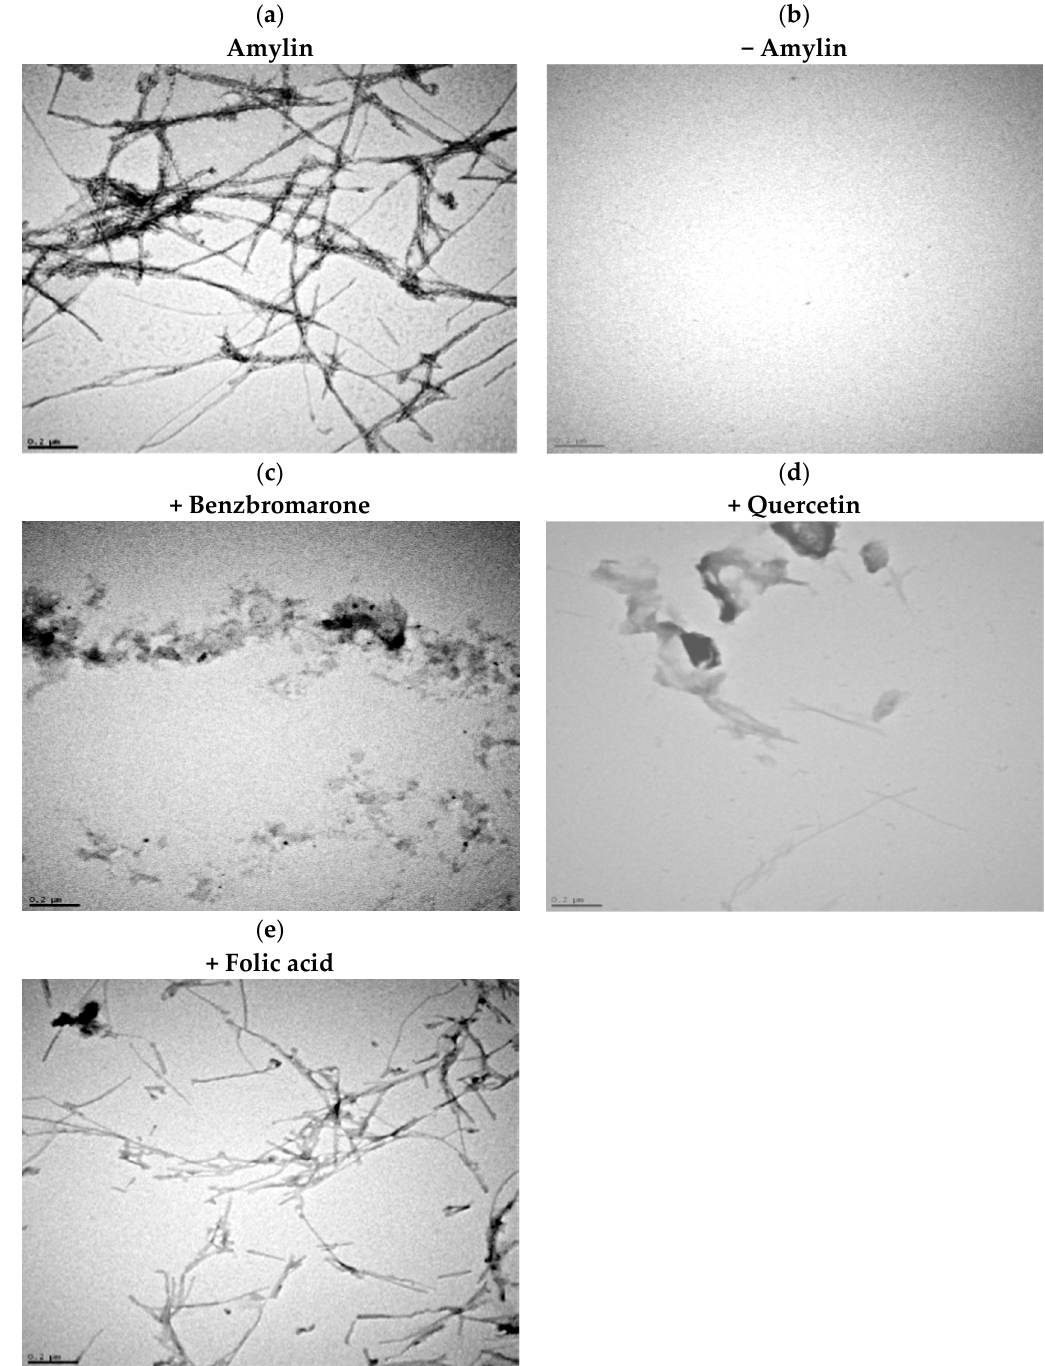
Figure 3. Amylin aggregation inhibition visualized using transmission electron microscopy (TEM). Amylin (8–37) at 50 µM was incubated in the presence or absence of the compounds (at 100 µM), fibers were negatively stained and imaged using TEM. Positive control (amylin alone): panel ( a ); negative control (no amylin): panel ( b ); amylin in presence of benzbromarone, quercetin, and folic acid: panels ( c , d , or e ), respectively. The length of the scale bars is 0.2 µm. Compounds strongly inhibit amylin amyloid fibril formation.